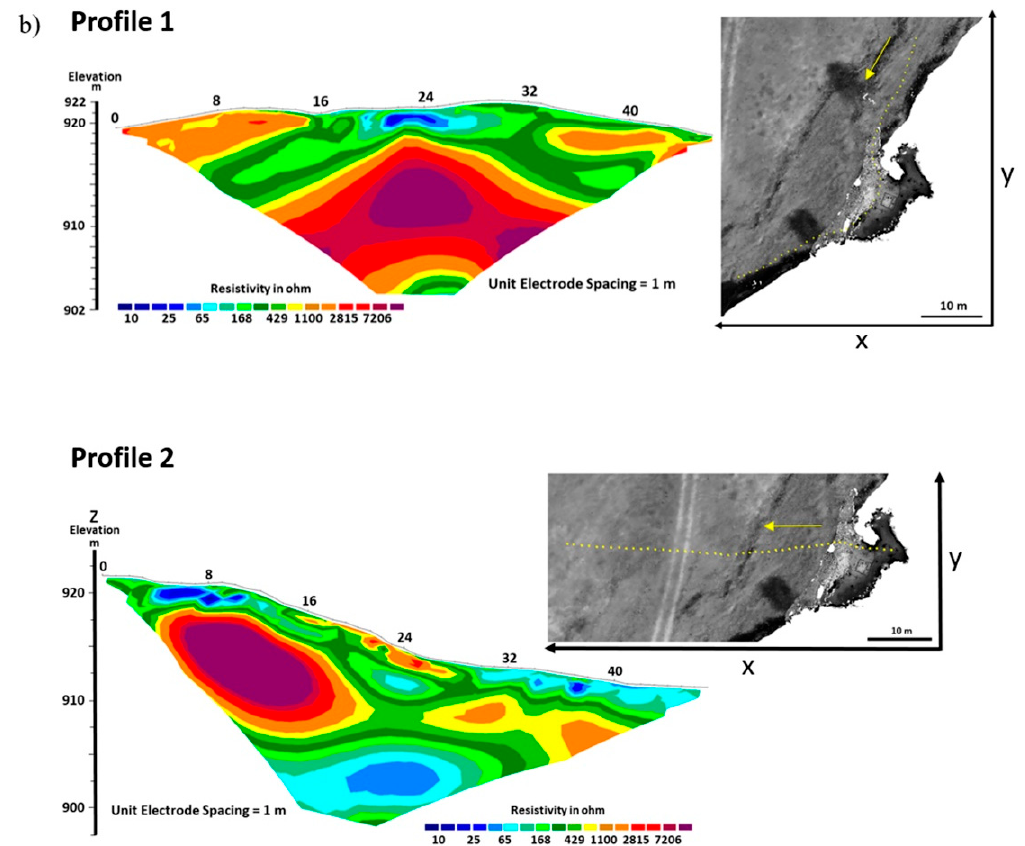
Figure 5. Syscal pro equipment: ( a ) general view of the different devices used and detailed view of the data acquisition unit (integrated in the corner of the bigger image) and; ( b ) results obtained form the 2 ERT profiles carried out on the shelter. Harm colors indicate higher values of electrical resistivity meanwhile cold colors indicate low values of electrical resistivity